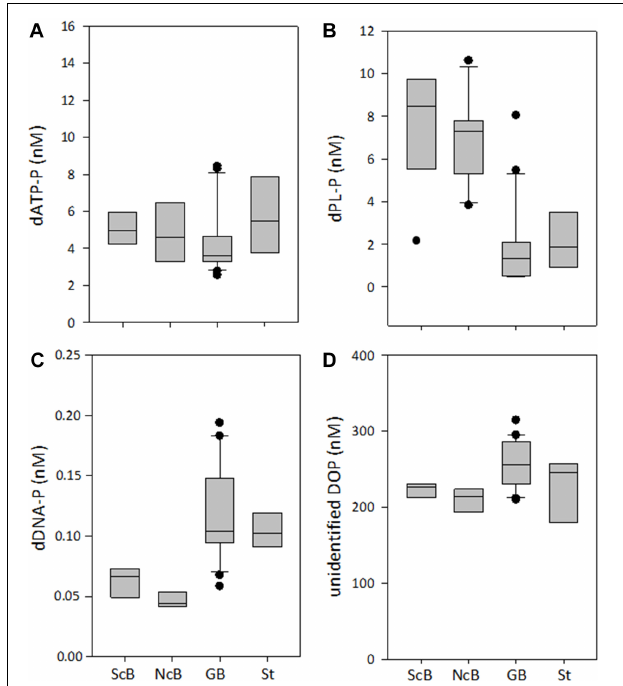
FIGURE 3 | Concentrations of the DOP compounds dATP-P (A) , dPL-P (B) , dDNA-P (C) , and of the unidentified DOP (D) in the two sub-regions of the transect [southern part (ScB); northern part (NcB)], in the eastern Gotland Basin (GB) and in the Storfjärden (St). The line inside the box represents the median value; the box is edged by the 25 and 75% percentile and the error bars indicate the 10 and 90% percentile.